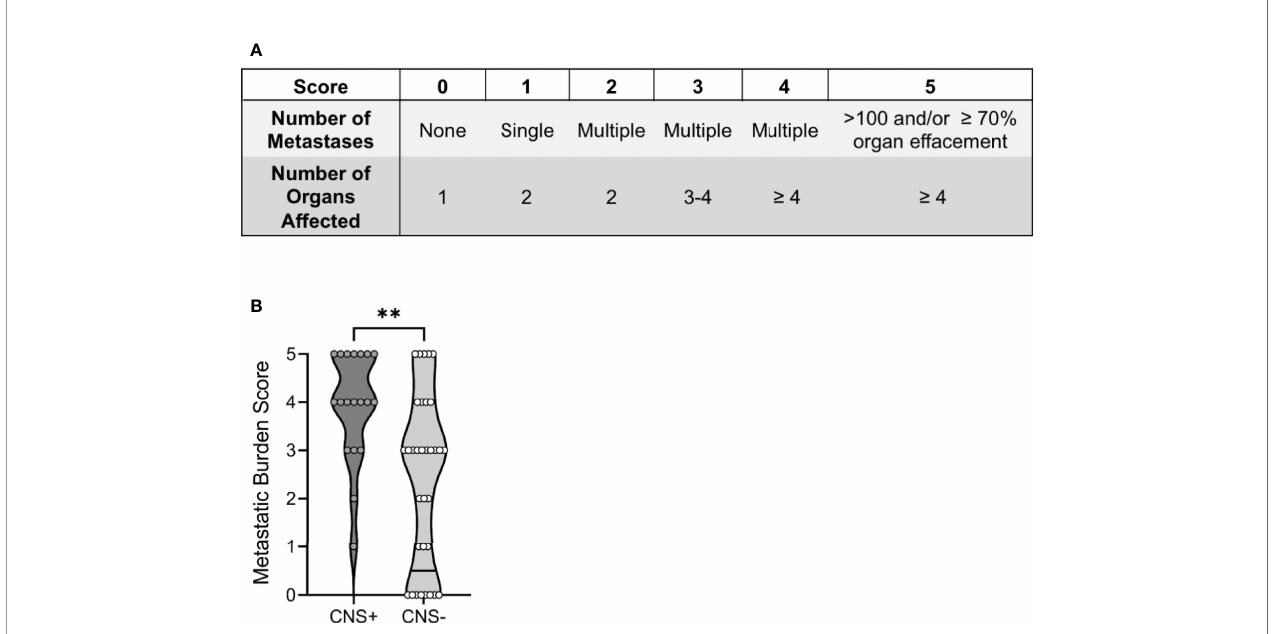
FIGURE 3 | Total burden of CNS and extra-CNS metastases in dogs with malignant melanoma. (A) The metastatic burden scoring system comprised the number of 1) metastases and 2) organs affected. (B) The median metastatic burden score was higher in CNS+ (n=19) dogs (p=0.0014). One CNS+ dog did not have an extra-neural post-mortem examination and therefore could not be assigned a score. Comparison based on Wilcoxon-Mann-Whitney rank sum test.